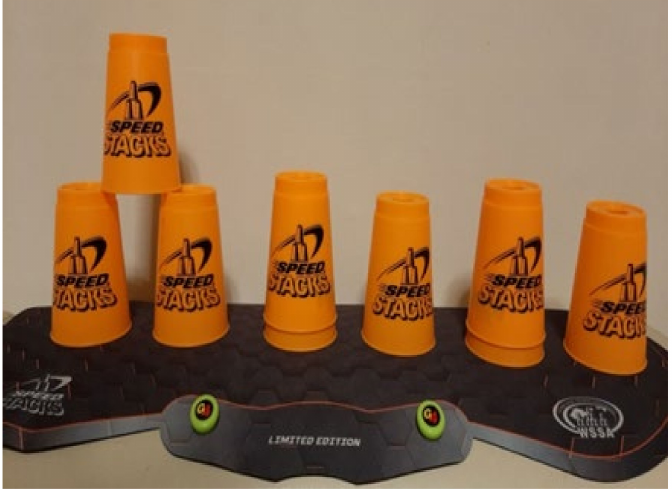
Figure 4. Lift the cup at the top of the stack of two cups on the left and place it on top of the two bottom cups to form a